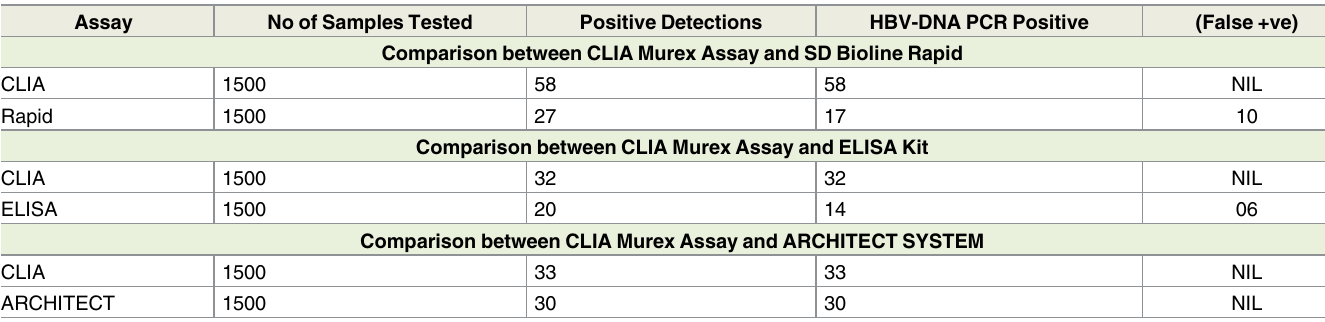
Table 5. Comparison of four assaysfor detection of HBV-DNA. Assay No of Samples Tested